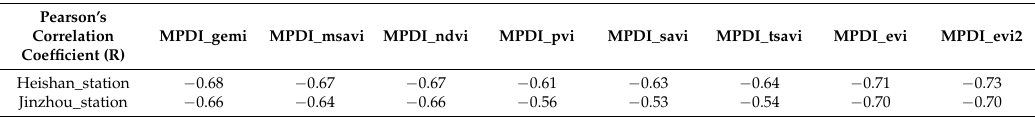
Table 4. Correlation coefficients between different drought indices with precipitation from CHIRPS at the Jinzhou and Heishan meteorological stations.